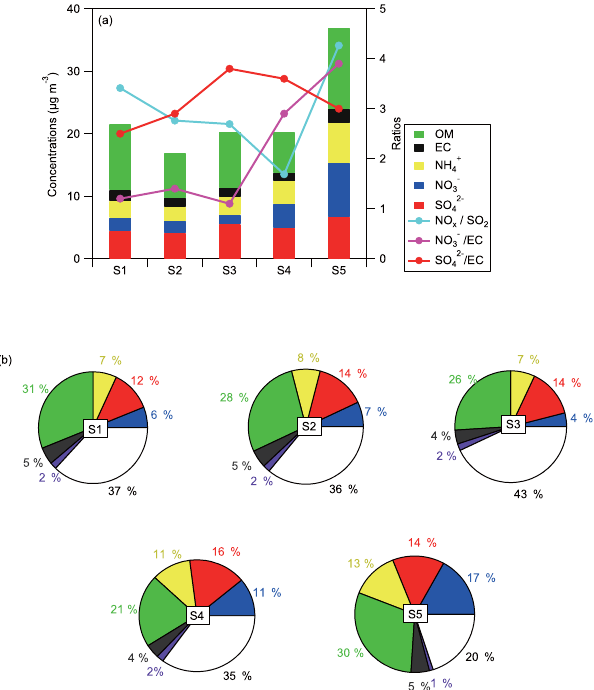
Figure 4. (a) Mean concentrations of major chemical components of PM 2 . 5 with respect to the different stages (S1 – S5). OM (or- ganic matter) was estimated based on OC multiplied by a factor of 1.8 in this study (Xing et al., 2013). The mass ratios of NO x / SO 2 , / EC, and SO 2 − / EC at each stage are also plotted. (b) Mass NO − 3 4 fractions of the measured aerosol chemical components from S1 to S5. The different colored numbers around the pie charts denote the mass fractions of major aerosol constituents, i.e., green for organic matter (OM), black for elemental carbon (EC), red for SO 2 − , dark 4 blue for NO − , yellow for NH + , purple for the sum of Ca 2 + , Mg 2 + , 3 4 K + , Na + , and Cl −